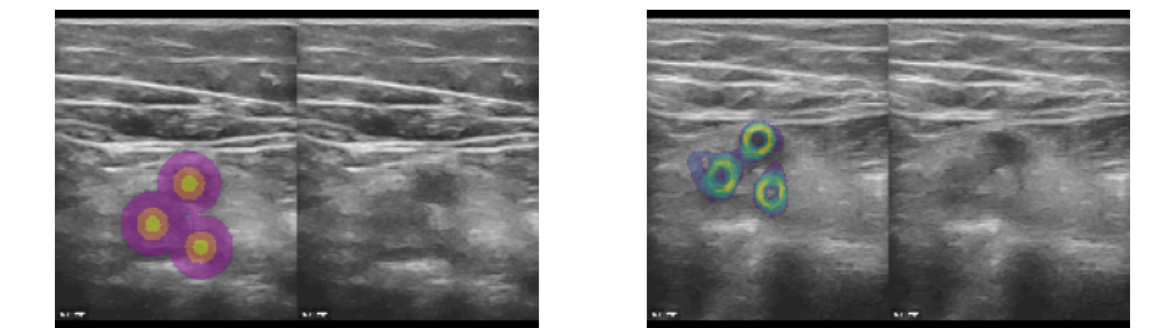
Figure 3. The concept was to employ sparse landmarks as spatial transformer (warping) loss by generating pseudo segmentation labels that could be directly used in affine augmentation and Dice loss functions. Based on either segmentation centroids or manual landmark coordinates (here vessel centres), we generated three concentric circles (heatmap labels) that defined the precise location, as well as a robust neighourhood of each landmark, for improved supervision. Left: Heatmap labels, along with original CoCoAI frame. Right: Tenth temporal frame in sequence with overlay of all warped heatmaps (middle label) averaged. It can be seen that the motion was very well compensated and only minimal deviations of the warped labels from their ground truth locations was